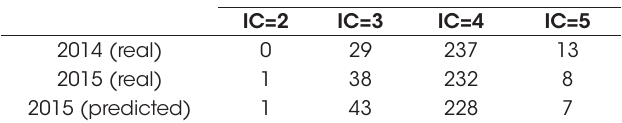
Number of Bridges Predicted by IC using proposal